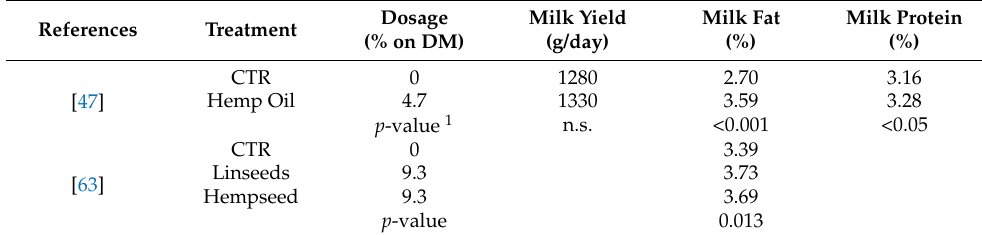
Table 7. Effect of hempseed oil on milk yield and quality of